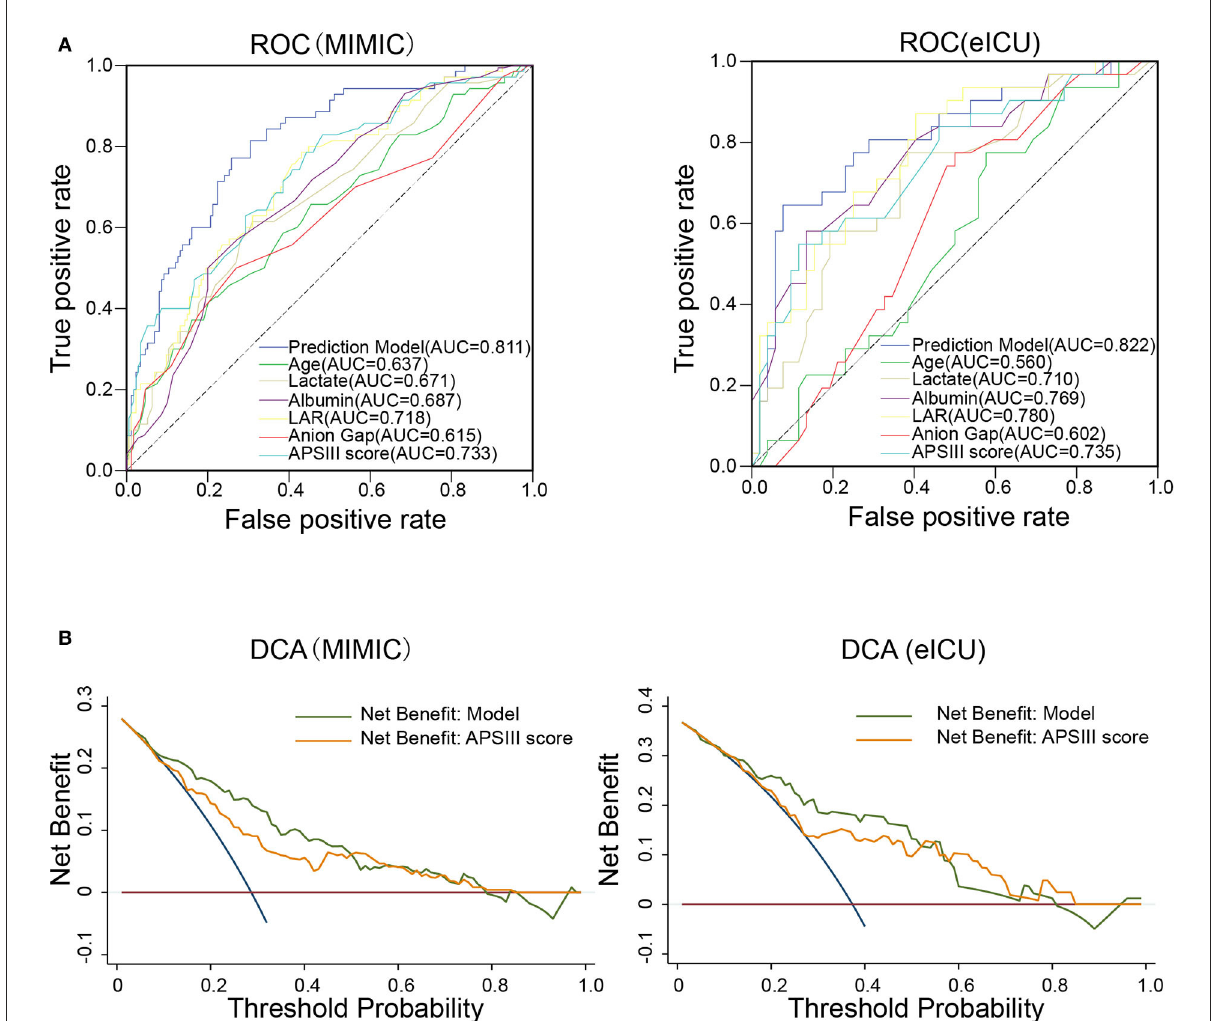
FIGURE3 Predictive performance of the prediction model. (A) Receiver operating characteristic (ROC) curve of different prognostic variables compared with the prediction model for the predictive performance of the in-hospital mortality in the training set (MIMIC-IV database) and validation set (eICU database). (B) Decision curve analysis (DCA) of the prediction model compared with APSIII in the training set and validation